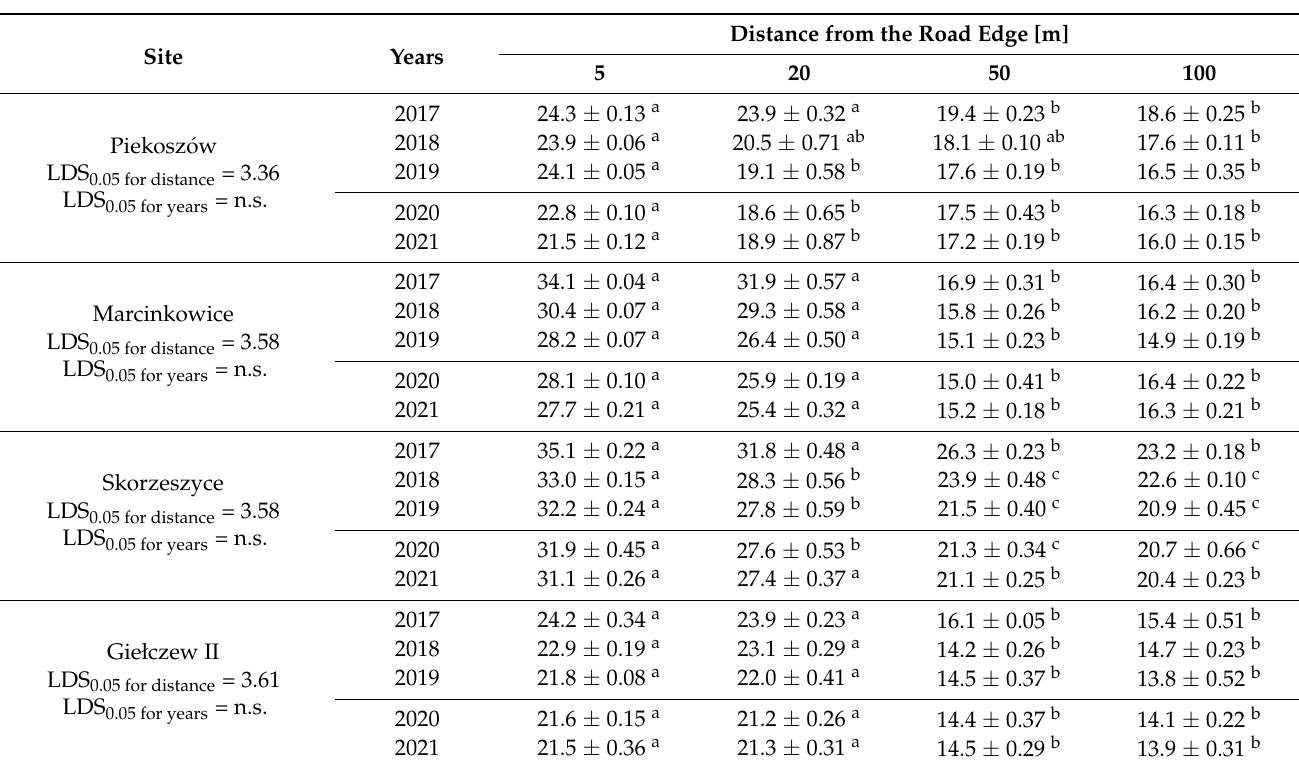
Table 7. Lead content (Pb in mgkg − 1 ) in soils before the COVID-19 pandemic (2017–2019) [28,29] and during the pandemic